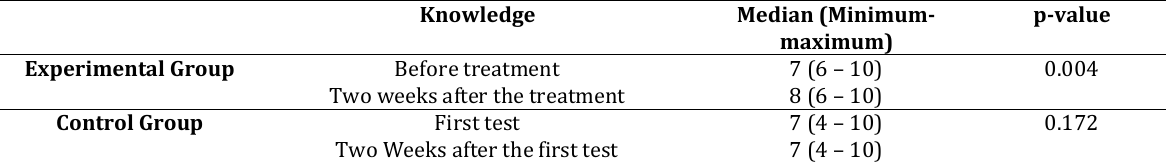
Table 1. Results of the Wilcoxon test analysis of the knowledge of what is a healthy lifestyle before and after treatment in the experimental and control groups.